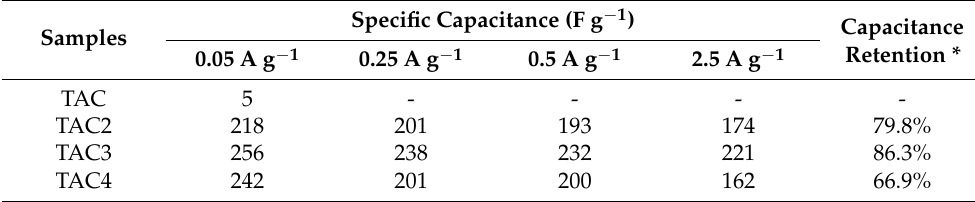
Table 2. The specific capacitances of the activated carbons at different current densities.